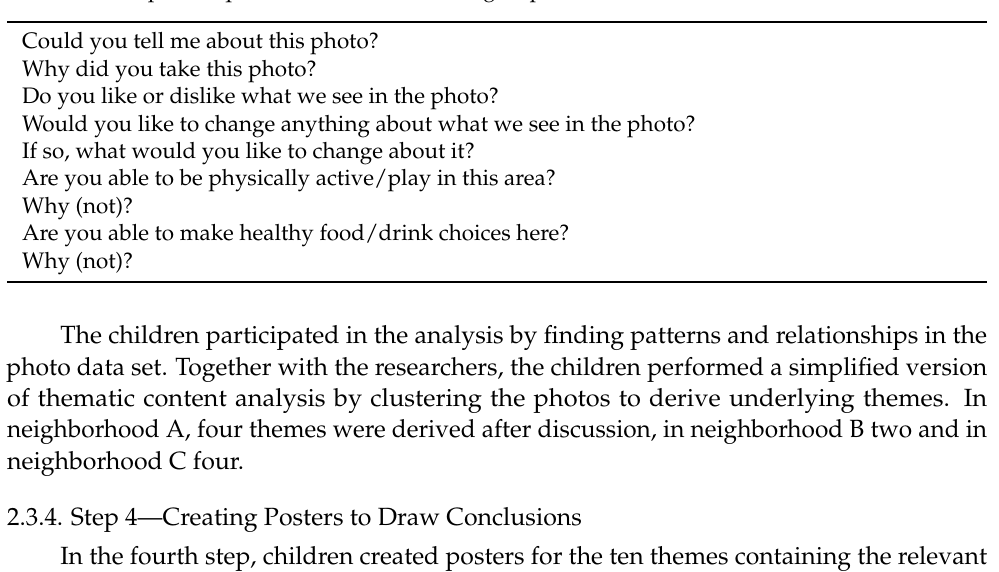
Table 2. Examples of questions asked in a focus group discussion with